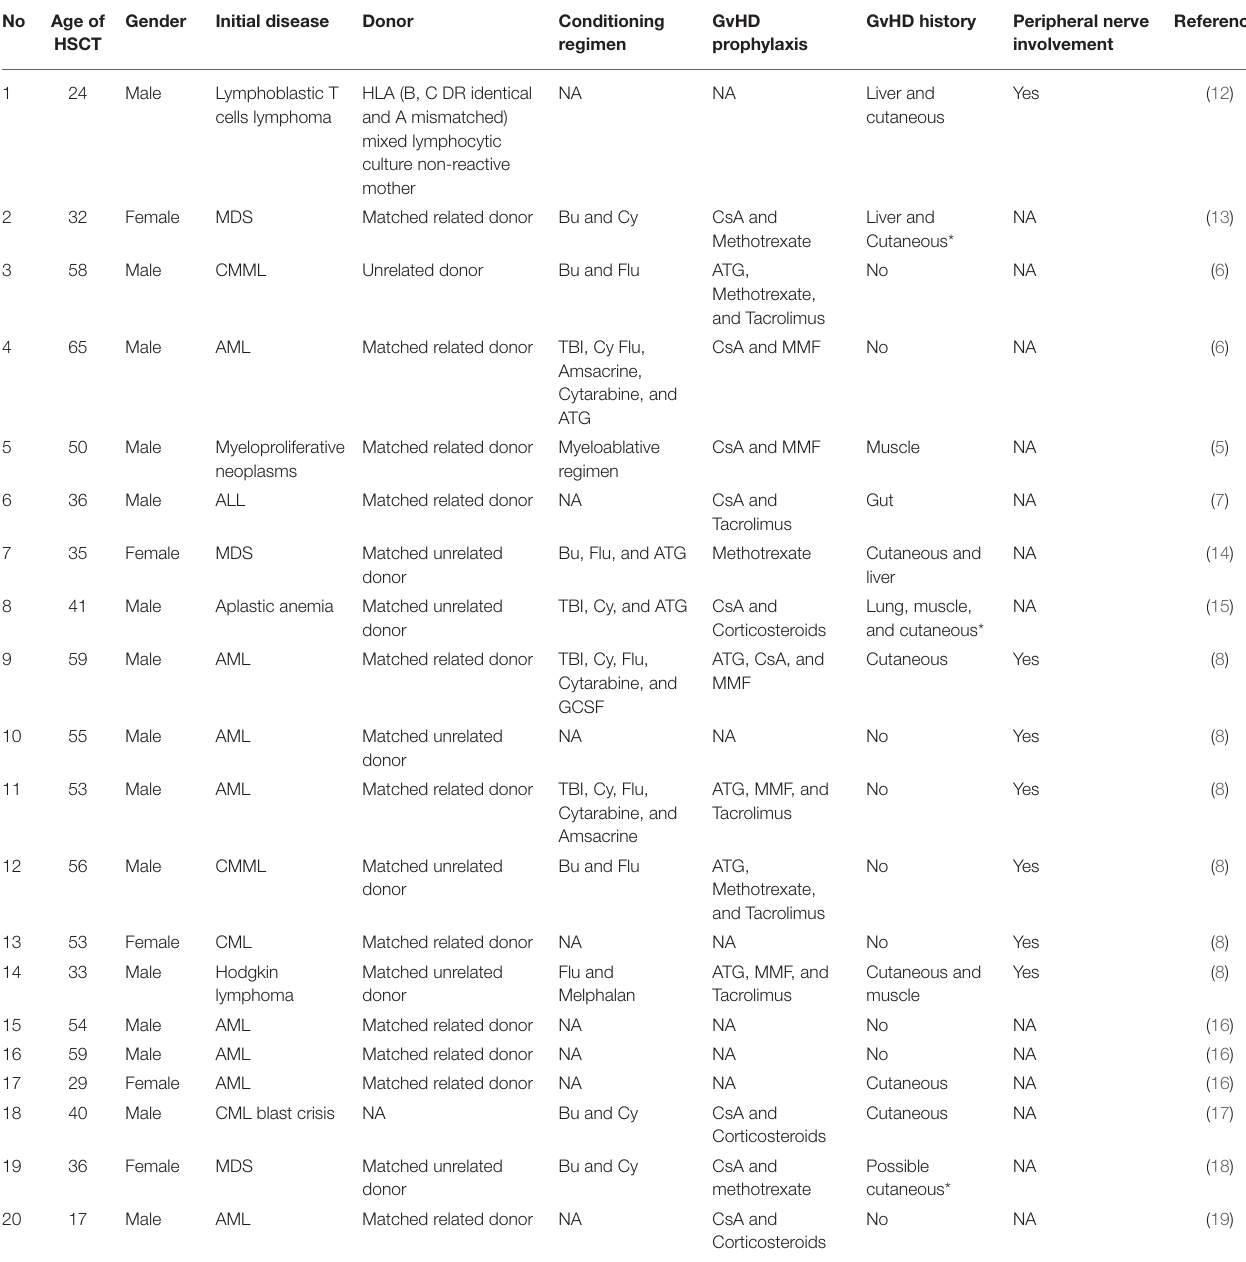
TABLE 1 | Demographic details, allogeneic HSCT procedures, GvHD and other immune mediated complications of post-transplant CNS demyelinating disorders. No Age of HSCT